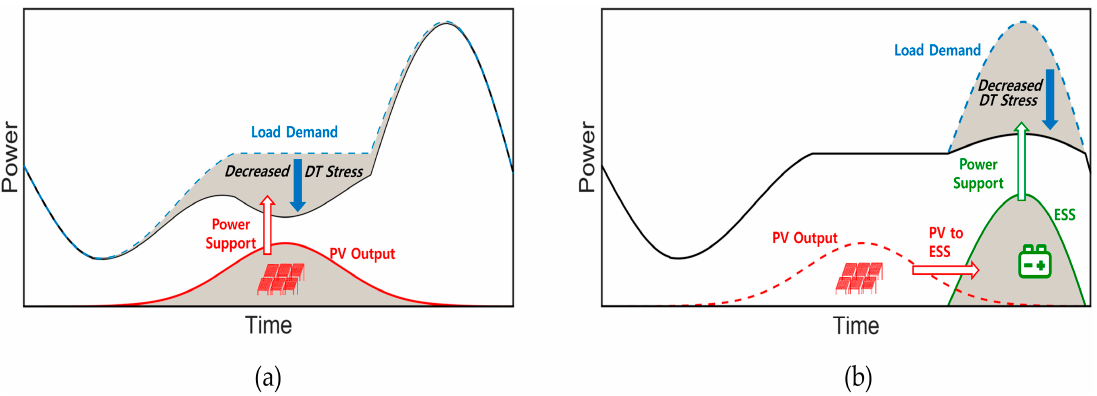
Figure 5. Photovoltaic (PV) integration approaches: ( a ) Passive Integration ( PPI ); ( b ) Active Integration ( API